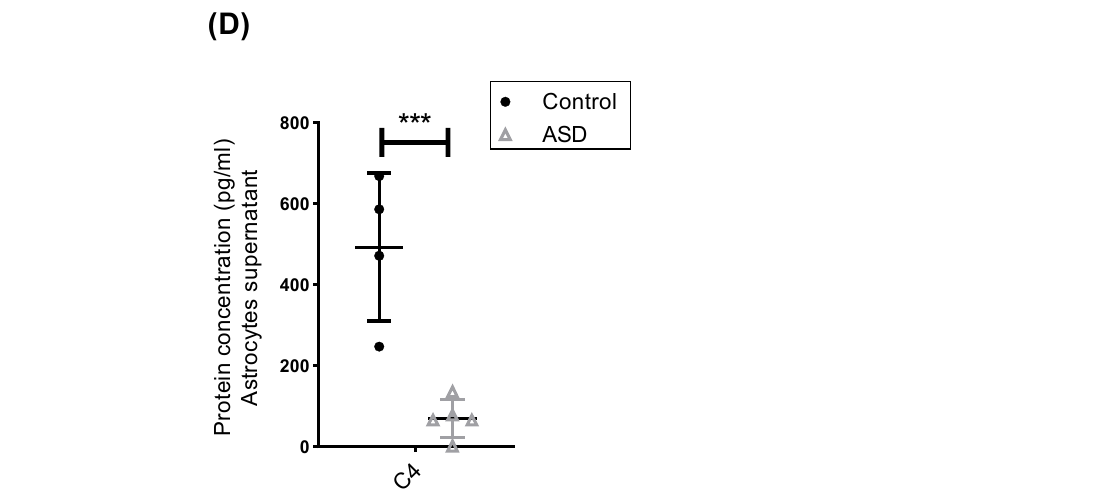
Figure 3. Secretion of complement proteins by iPSC-derived neural progenitor cells, neurons and astrocytes. Protein levels (pg/mL) of complement components and regulators measured by multiplex assays in culture supernatants from ( A ) iPSC-derived NPCs of control ( n = 4) and ASD ( n = 5) subjects; ( B ) iPSC-derived neurons of control ( n = 4) and ASD ( n = 5) subjects; ( C ) iPSC-derived astrocytes of control ( n = 2) and ASD ( n = 4) subjects. ( D ) Protein levels of C4 in culture supernatants of iPSC-derived astrocytes of control ( n = 4) and ASD ( n = 4) subjects were also assessed by using an ELISA assay. A significant decrease in the secretion levels of C4 was observed in astrocytes derived from individuals with ASD compared to control astrocytes. *** p < 0.001.